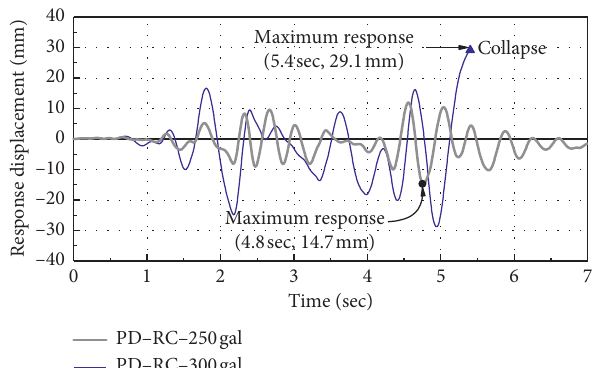
Figure 15: Response displacement-time history relationships of the PD-RC control specimen during pseudodynamic testing at 250 and 300gal.